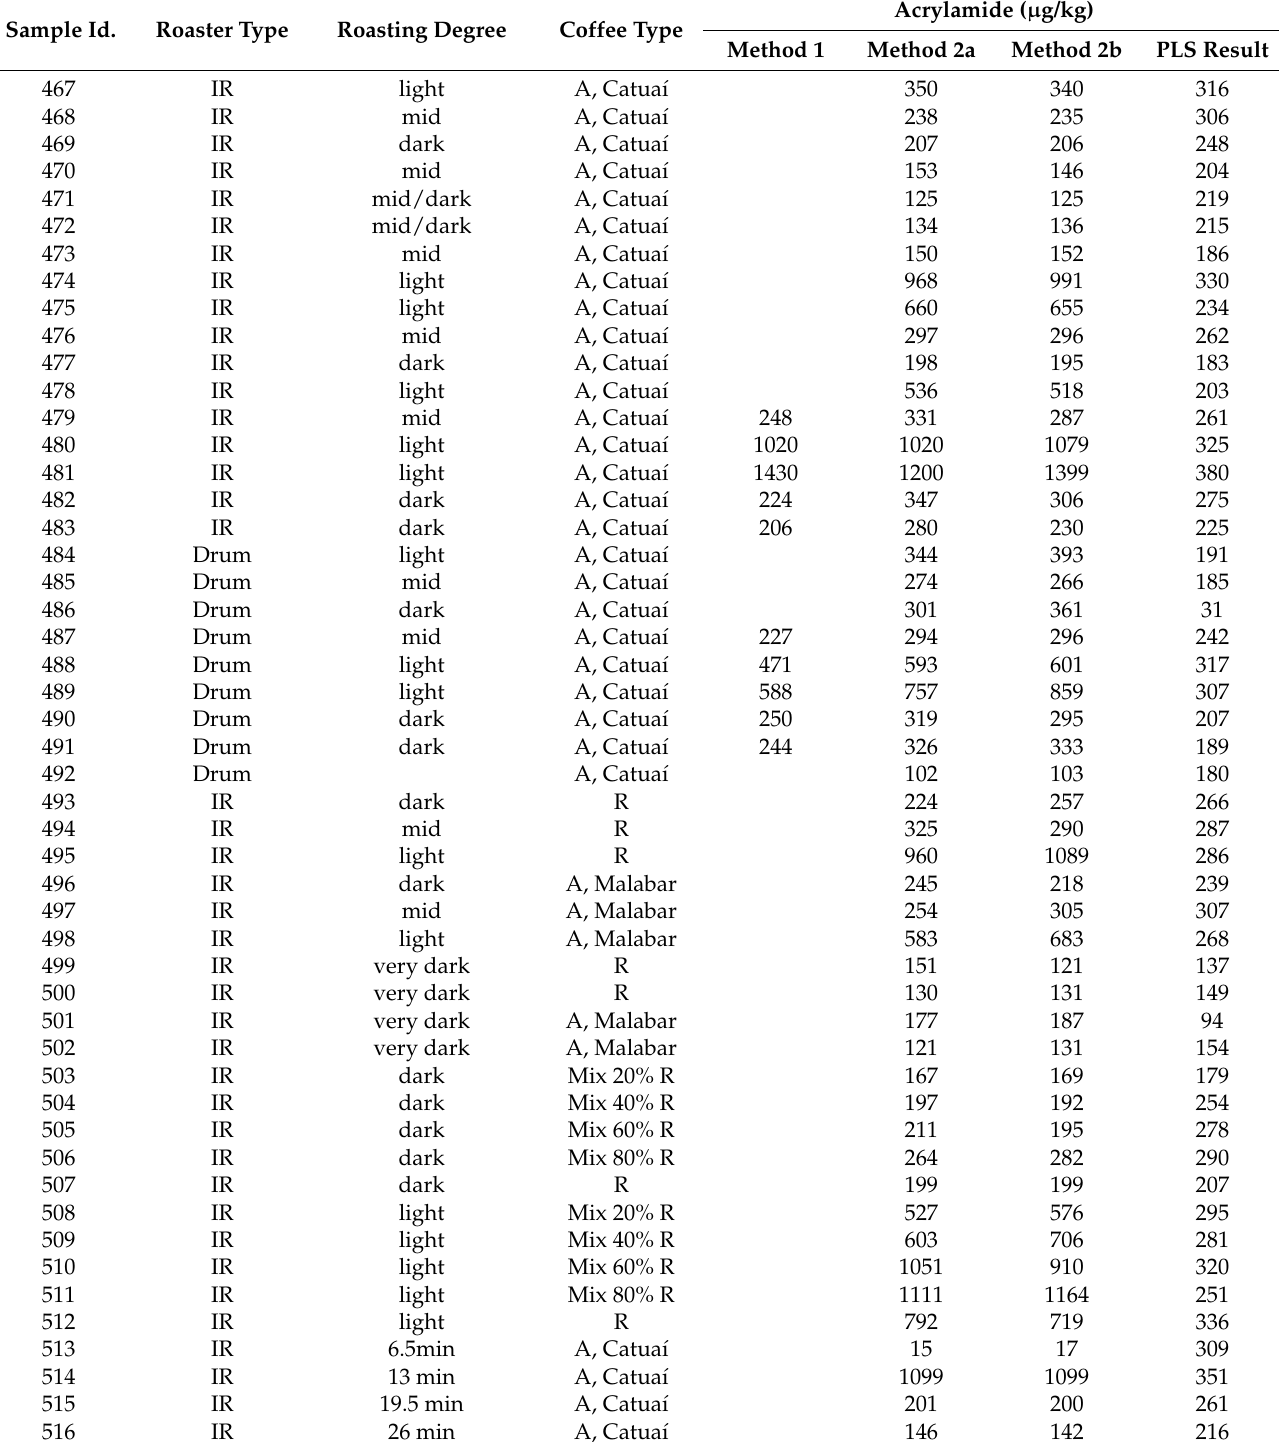
Table A2. Results of the test set of 50 coffee samples (IR = infrared roaster, A = Coffea arabica , R = C. canephora , and blend (mix) with A, Catua í